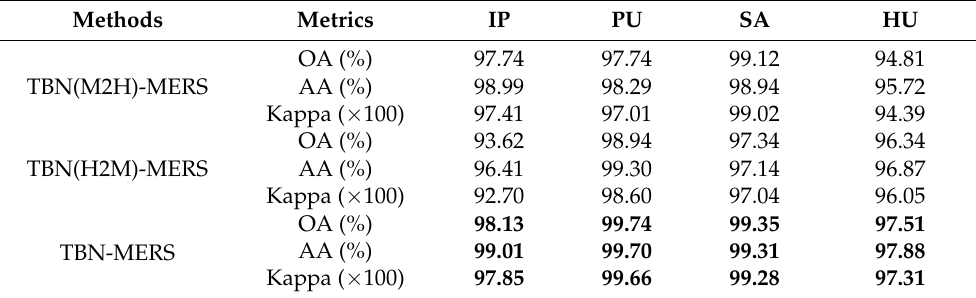
Table 9. Classification results of TBN(M2H)-MERS, TBN(H2M)-MERS, and